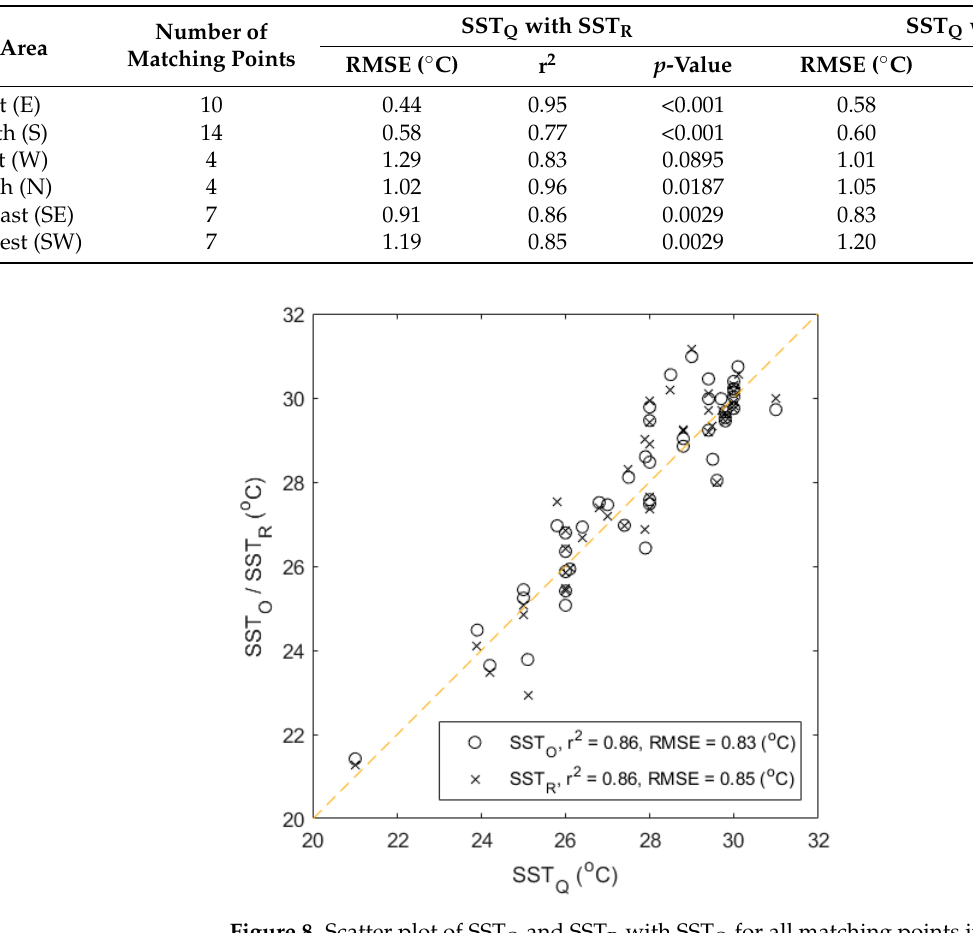
Table 3. Statistical results between SST M and SST R /SST O .